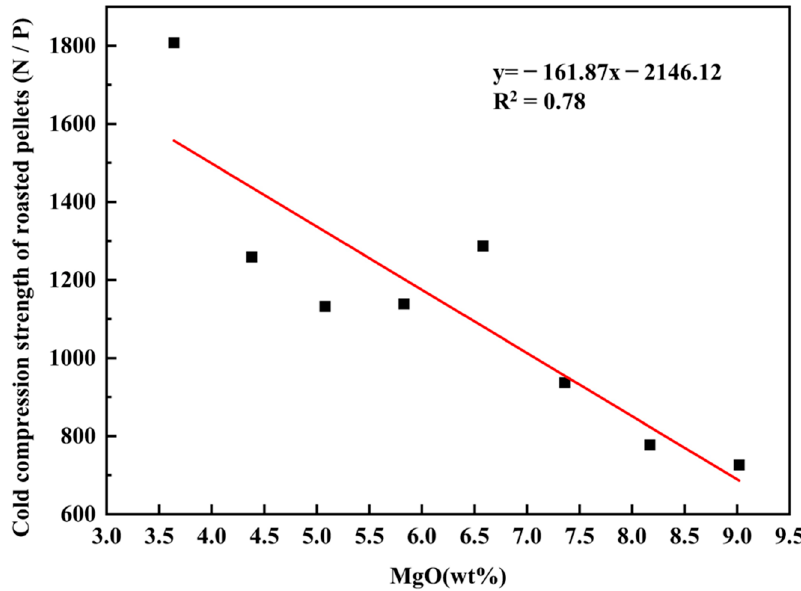
Figure 7. Effect of MgO content on the cold compression strength of roasted